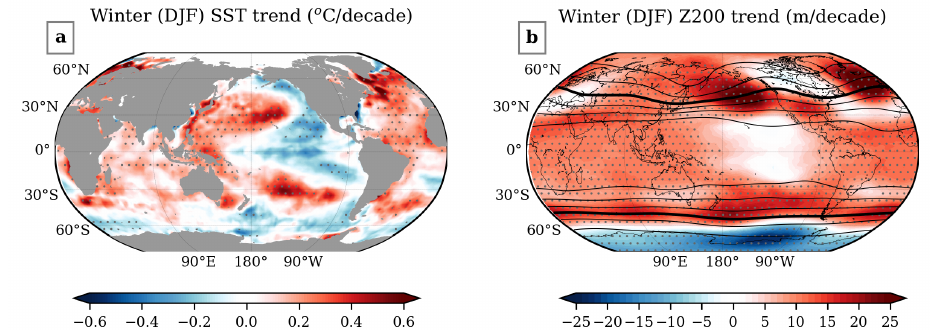
Figure 10. ( a ) SST trends (Data: HadISST1.1) and ( b ) geopotential height trend at 200 hPa (Data: SSTreal control ensemble mean). Trends were calculated for the 1980–2012 period. The black contours in ( b ) show the corresponding climatological values of Z200 from the control ensemble (the bold line is the 1.15 × 10 4 m contour and the contour interval is 250 m). Dotted areas indicate